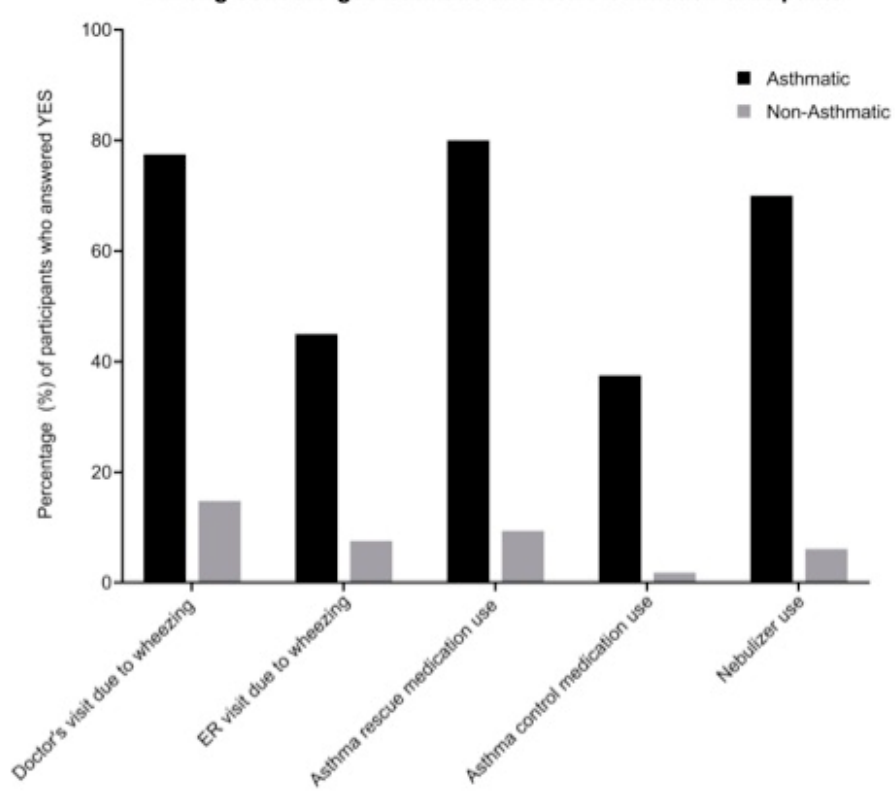
Figure 2. Use of healthcare resources and respiratory medications among school-age asthmatic and nonasthmatic participants. Bars represent percentage of asthmatics ( n = 80; black bars) and nonasthmatics ( n = 277; gray bars) who were reported to have utilized any of the listed healthcare resources or medications in the past 12 months.